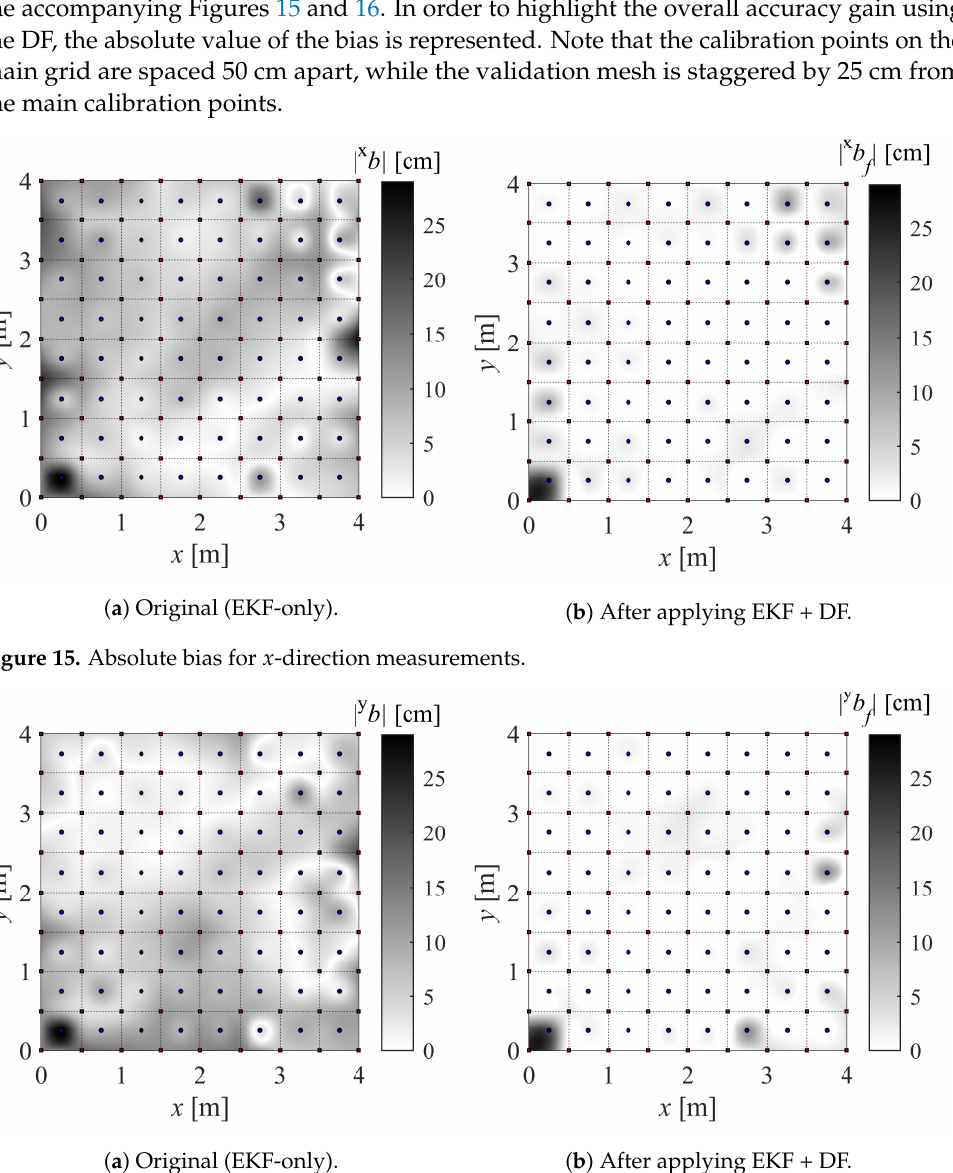
Figure 16. Absolute bias for y -direction